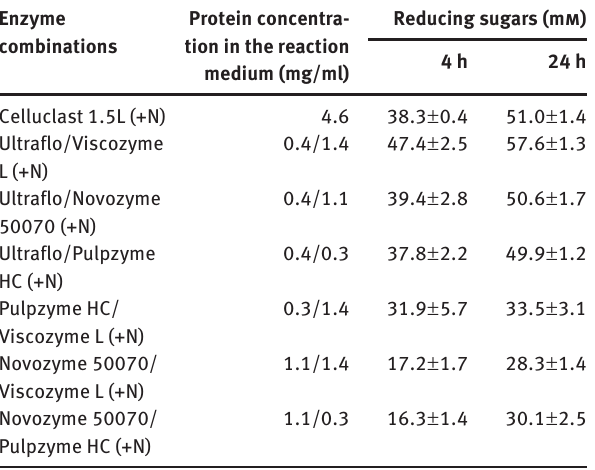
Table 3 Enzymatic saccharification of regenerated corn cob by combination of different enzymatic complexes.